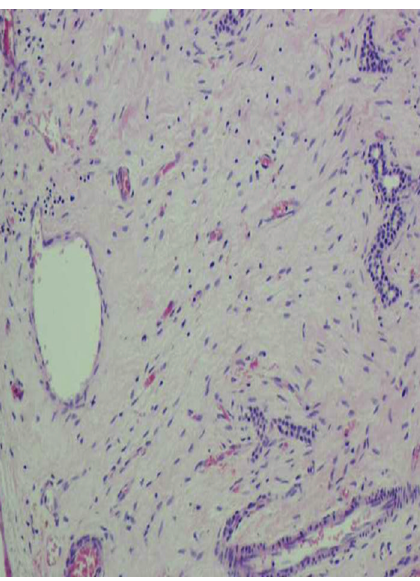
Figure 3: Histopathological image with fluid-filled lakes and devoid of